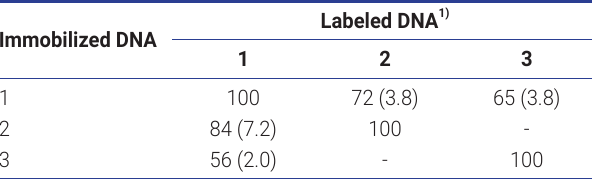
Table 2. Tolerance of Bacillus sp. TAT105, Bacillus thermolactis , and Bacillus kokeshiiformis to NaCl and NH